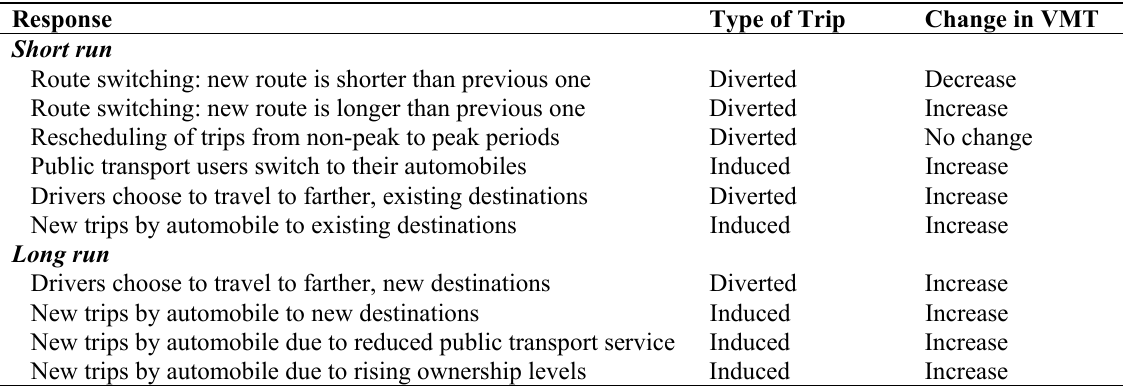
Table 2. Behavioral responses to network capacity